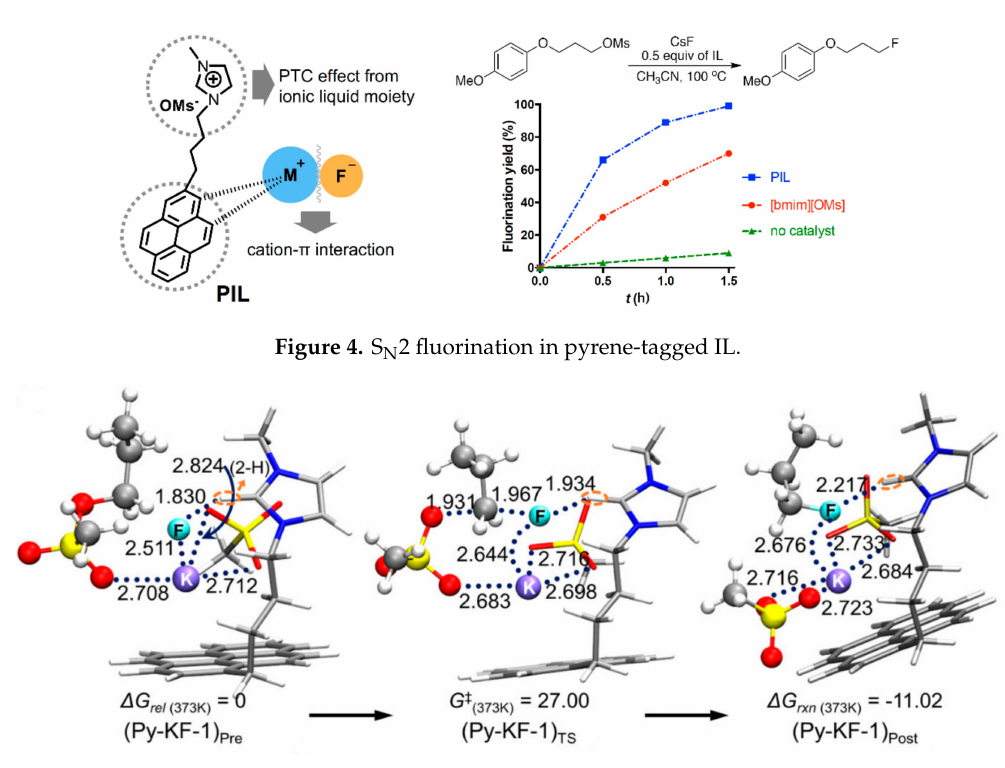
Figure 5. Mechanism of S N 2 fluorination catalyzed by pyrene-tagged IL. M06-2X / 6-311G ** method for C, H, O, N, S atoms, LANL2DZ24 basis set with relevant e ff ective core potential for alkali metal elements (Cs, K). Gaussian 09 set of